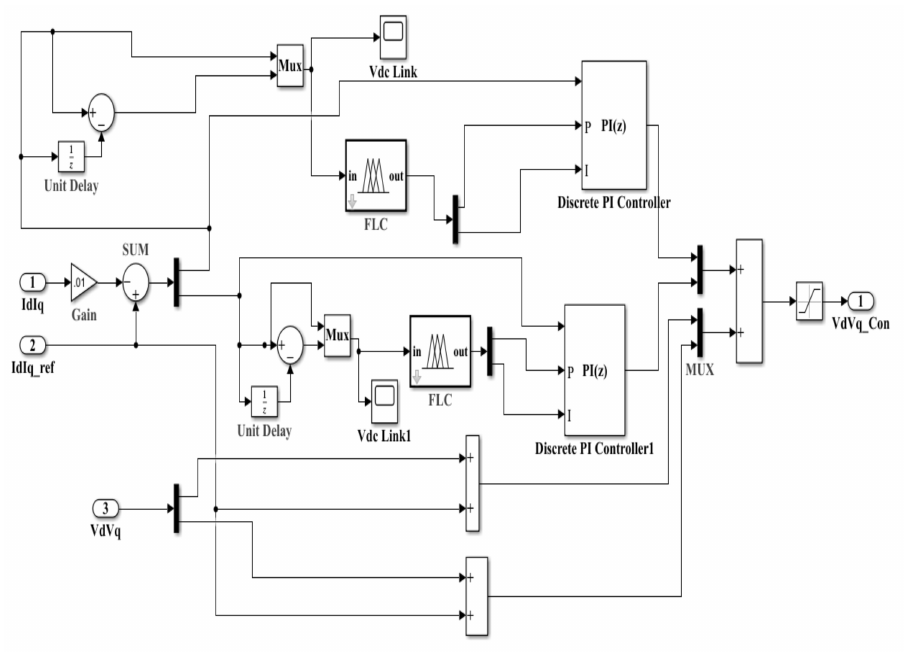
Figure 2. Simulink model of fuzzy-PI inverter